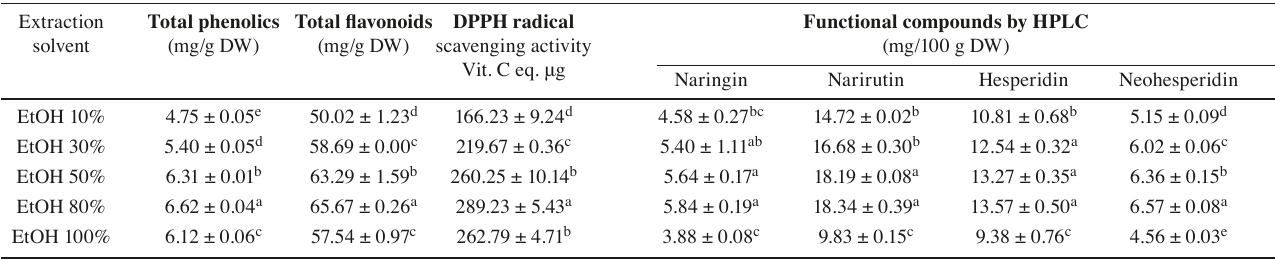
Tab. 3: Functional components of yuzu extracts by extraction